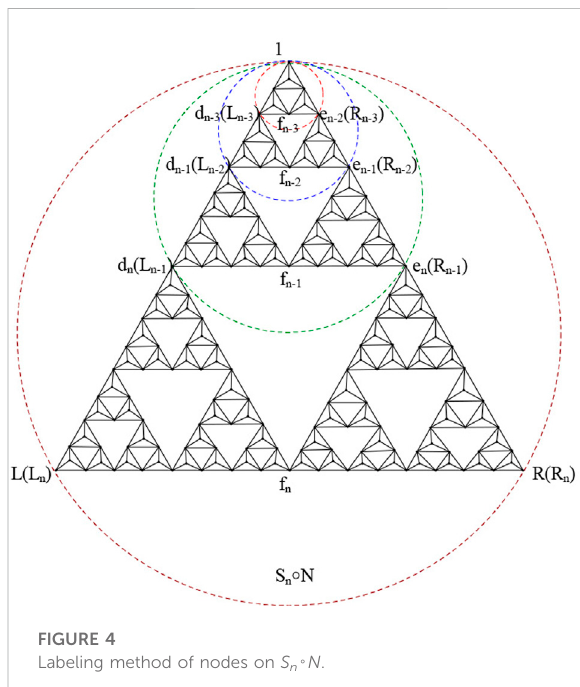
FIGURE 4 Labeling method of nodes on S n ◦ N